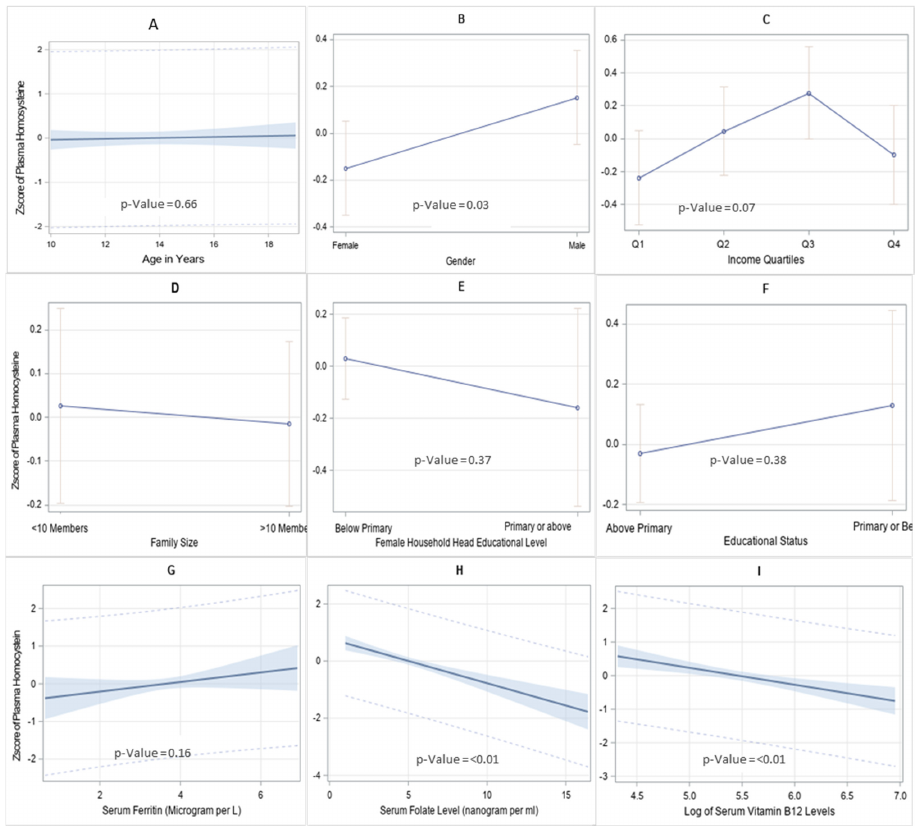
Figure 1. Associations between plasma homocysteine levels. Associations are shown for plasma homocysteine Z-score and age ( A ), gender ( B ), income ( C ), family size ( D ), educational status of the female household head ( E ), education level of the participant ( F ), serum ferritin ( G ), folate ( H ), and vitamin B12 ( I ). Means and 95% confidence limits are presented for gender and income quartiles from t -test and ANOVA, respectively. For age, serum ferritin, folate, and B12, regression lines with 95% confidence interval are shown, while for gender, income quartiles, family size, educational level of female household, and educational status of the respondents, mean Zscore of plasma homocysteine for the groups with 95% confidence intervals are shown. Logistic regression analysis, both uni-variable and multivariable, of risk factors for hyperhomocysteinemia is presented in Table 3. No significant associations were observed between hyperhomocysteinemia and age, gender, and educational status. Participants from small families (<10 household members) had higher odds (OR 3.64; 95% CI of 1.56 to 8.49; p < 0.01) of homocysteinemia as compared to large families. A significantly lower levels of serum vitamin B12 and folate were observed among participants with hyperho- mocysteinemia (homocysteine levels ≥ 15 µmol/L). Multivariate logistic regression analy- sis revealed a statistically non-significant positive association between serum homocyste- ine and serum ferritin (OR 1.55, 95% CI of 0.93 to 2.57; p = 0.09), whereas a strong inverse association of homocysteineimia was observed with serum vitamin B12 (OR 0.29; 95% CI of 0.14 to 0.62; p < 0.01) and folate (OR 0.1; 95% CI of 0.03 to 0.27; p < 0.001).